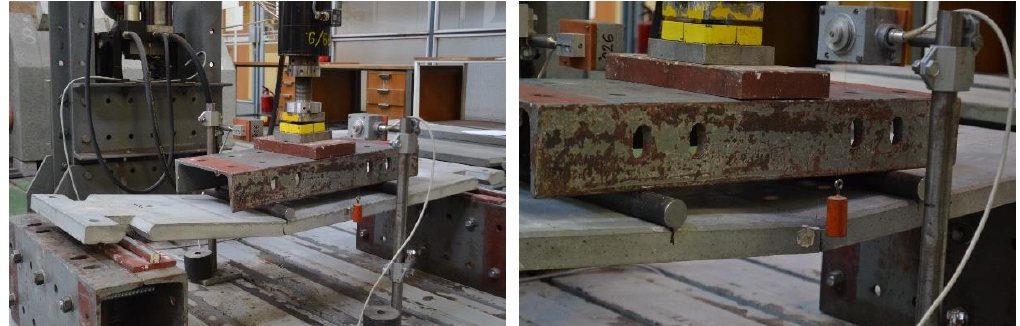
Figure 2. Experimental flexural test campaign.